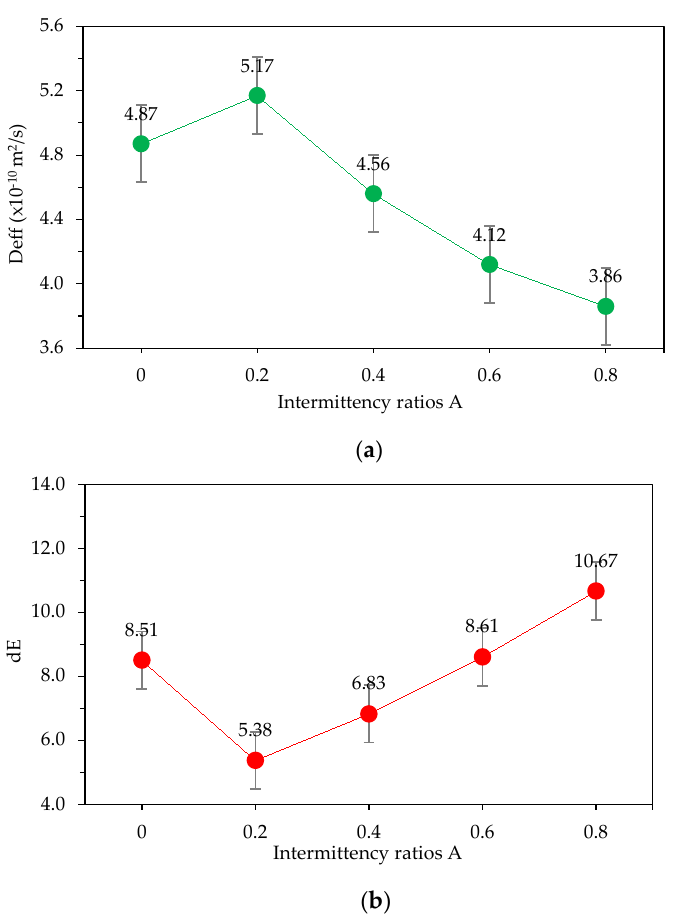
Figure 10. Effect of intermittent drying on ( a ) moisture diffusion coefficient and ( b ) color change.